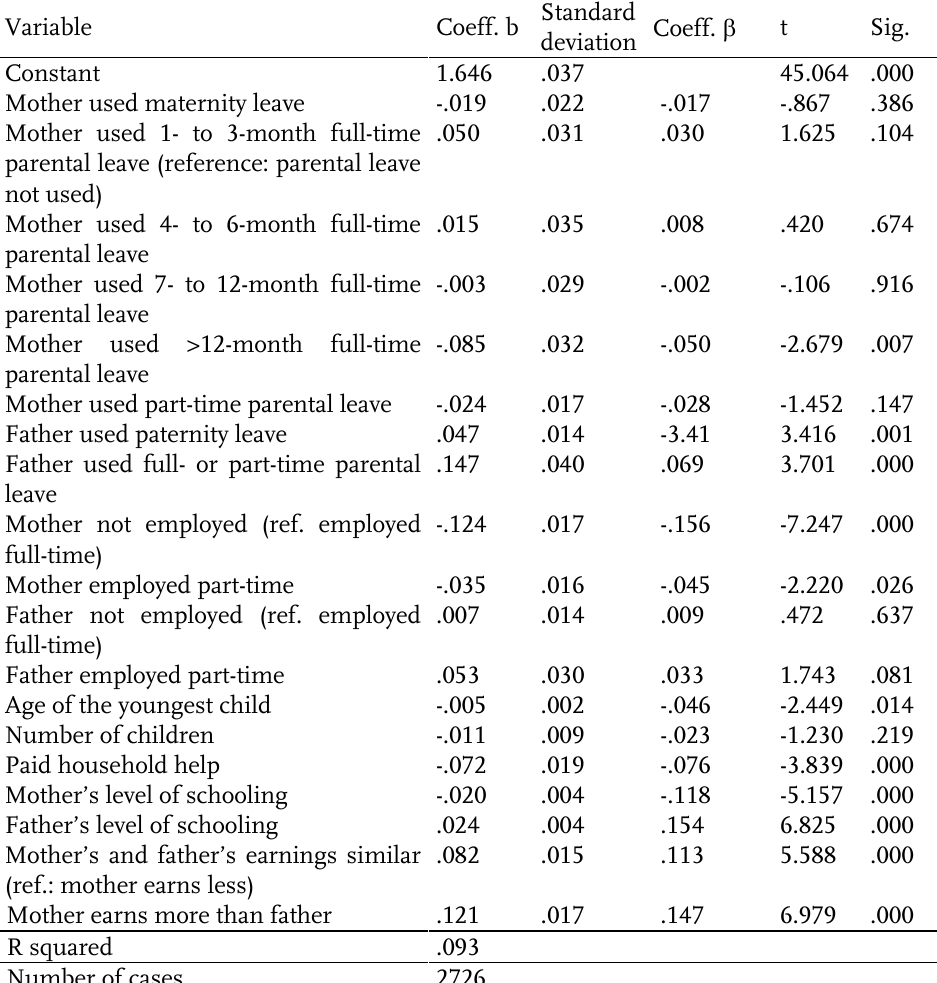
Table 2 : Factors conditioning childcare practices among parents Variable Coeff. b